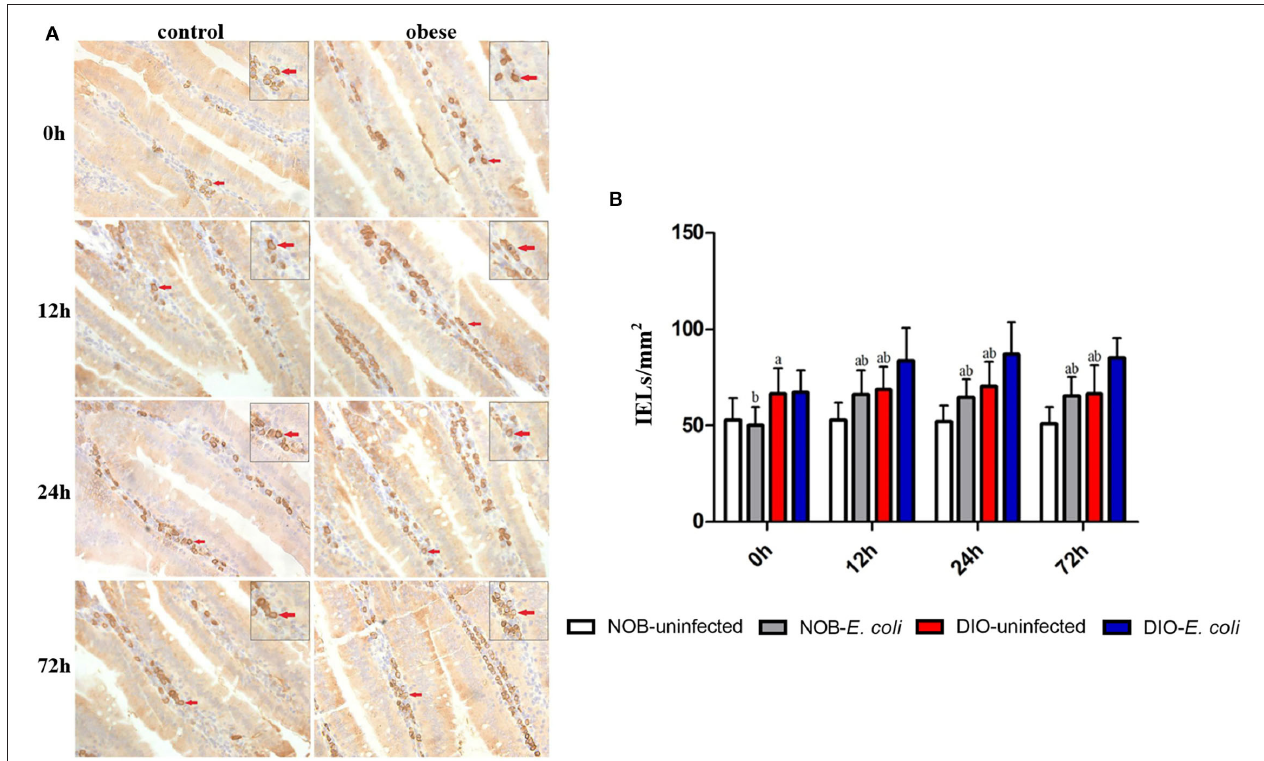
FIGURE 3 | The counting of duodenal IgA + lamina propria (LPLs) of each group in 0, 12, 24, and 72h post-infection. (A) Representative photomicrographs of immunostaining of IgA + cells in the duodenum of mice in control (NOB- E. coli ) and obese (DIO- E. coli ) group. 0, 12, 24, and 72h were the time points after the mice were nasally instilled with E. coli . Images were taken at 400 × magnification. n = 8 mice per group. The red arrows point to the IgA + cells in the lamina propria of duodenum. The small picture in the upper right corner of each picture is a magnified IgA + cells area. (B) Statistical analysis of duodenal IgA + LPLs counts per mm 2 in immunostaining sections of each group in 0, 12, 24, and 72h post-infection. a, p < 0.05 compared with group NOB-uninfected; A, p < 0.01 compared with group NOB-uninfected; b, p < 0.05 compared with group DIO- E. coli ; B, p < 0.01 compared with group DIO- E. coli